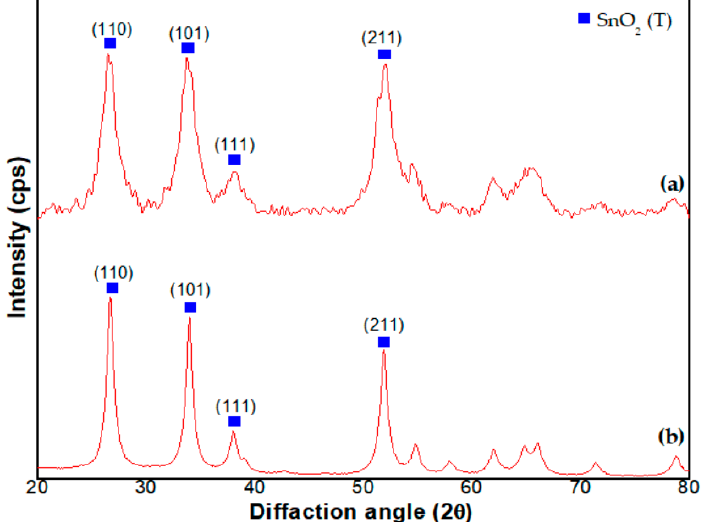
Figure 4. X-ray diffraction peaks of SnO 2 -Pd NPs synthesized with ( a ) in situ method and ( b ) current method, respectively.